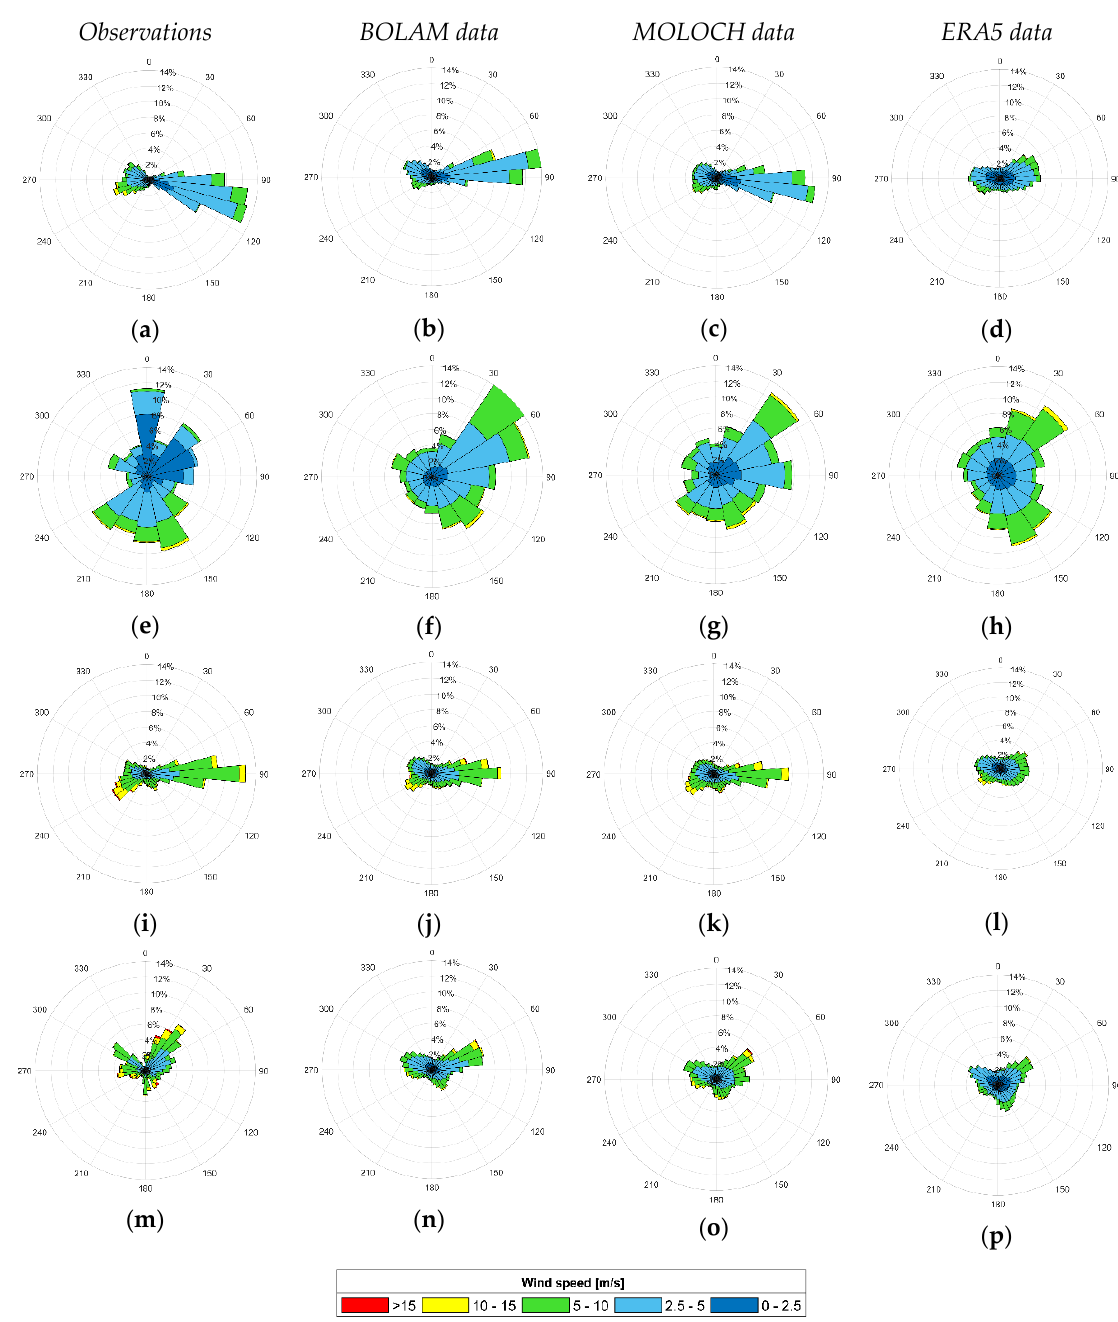
Figure 10. Wind roses of velocity and direction for: ( a ) Bocca d’Arno (no. 1) wind station, ( b ) Bocca d’Arno BOLAM point, ( c ) Bocca d’Arno MOLOCH point, ( d ) Bocca d’Arno ERA5 point, ( e ) Capalbio (no. 2) wind station, ( f ) Capalbio BOLAM point, ( g ) Capalbio MOLOCH point, ( h ) Capalbio ERA5 point, ( i ) Livorno offshore (no. 6) wind station, ( j ) Livorno offshore BOLAM point, ( k ) Livorno offshore MOLOCH point, ( l ) Livorno offshore ERA5 point, ( m ) Vada (no. 11) wind station, ( n ) Vada BOLAM point, ( o ) Vada MOLOCH point, ( p ) Vada ERA5 point.